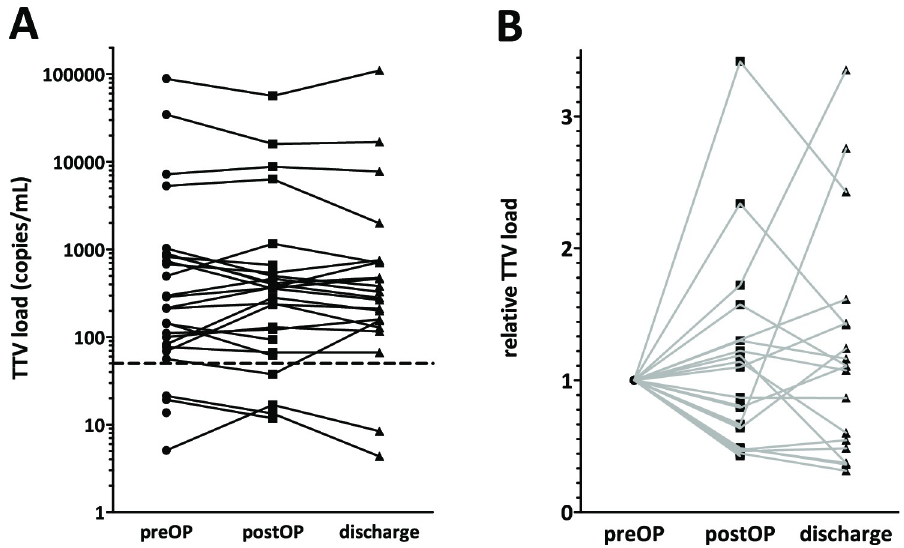
Fig 4. Perioperative changes in TTV DNA levels during resection of early stage lung tumors prior to the operation, on the first postoperative day and at discharge. (A) Absolut TTV DNA copy numbers showed minor changes in TTV plasma DNA levels. (B) Relative TTV loads normalized to the preoperative value shows no unequivocal direction of changes on postoperative day 1 or at discharge.